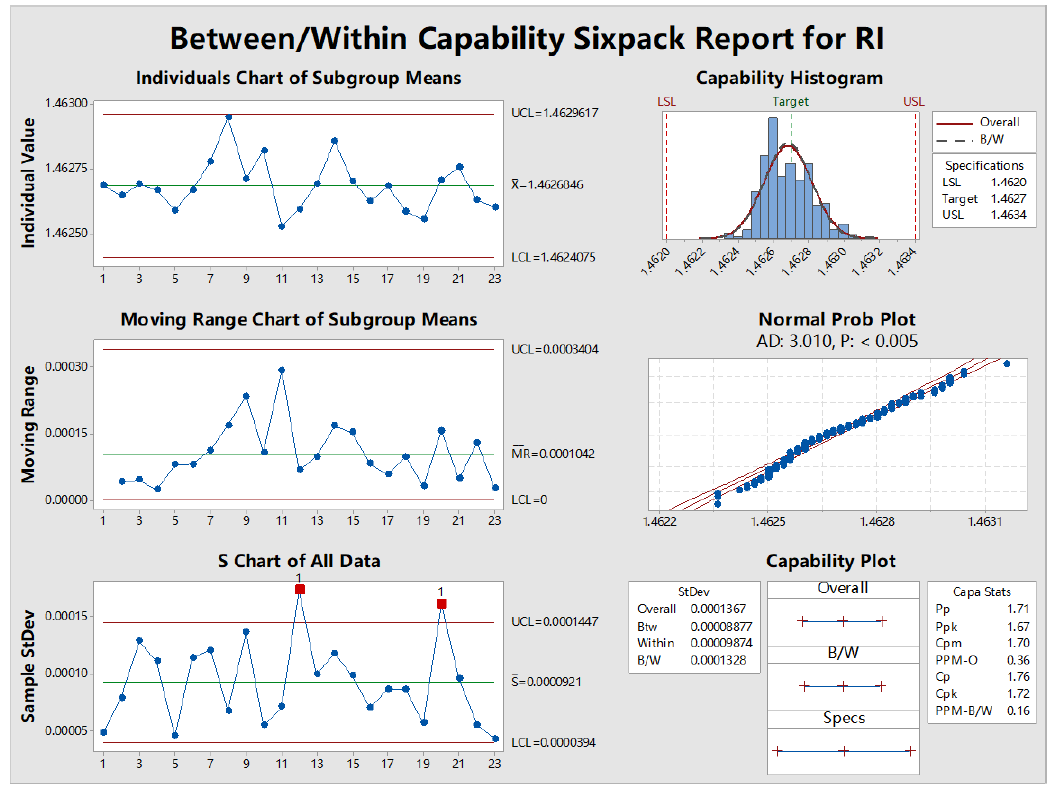
Figure 2. RI between/within capability sixpack report results for the 23 lots.